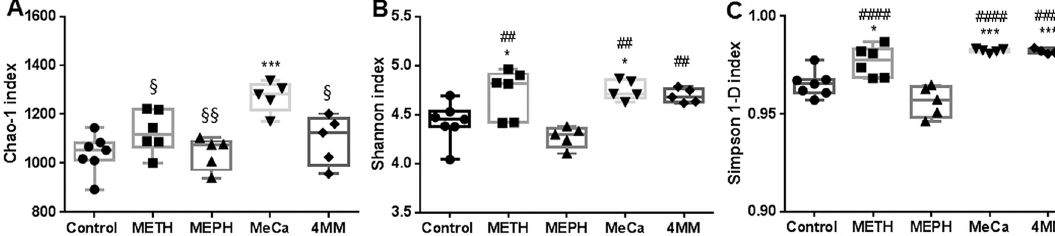
Fig 1. Effects of study drugs on α -diversity. The α -diversity metrics Chao-1 richness estimator (A), Shannon diversity index (B) and Simpson (1-D) index (C) were determined for 16S rRNA gene profiles of caecum contents harvested 1 day after treatment. The individual values for all subjects in each treatment group are included in each box plot. � , p < 0.05 or ��� p < 0.001 compared to control; # p < 0.05, ## p < 0.01 or #### p < 0.0001 compared to Meph; § p < 0.05, or §§ p < 0.01 compared to